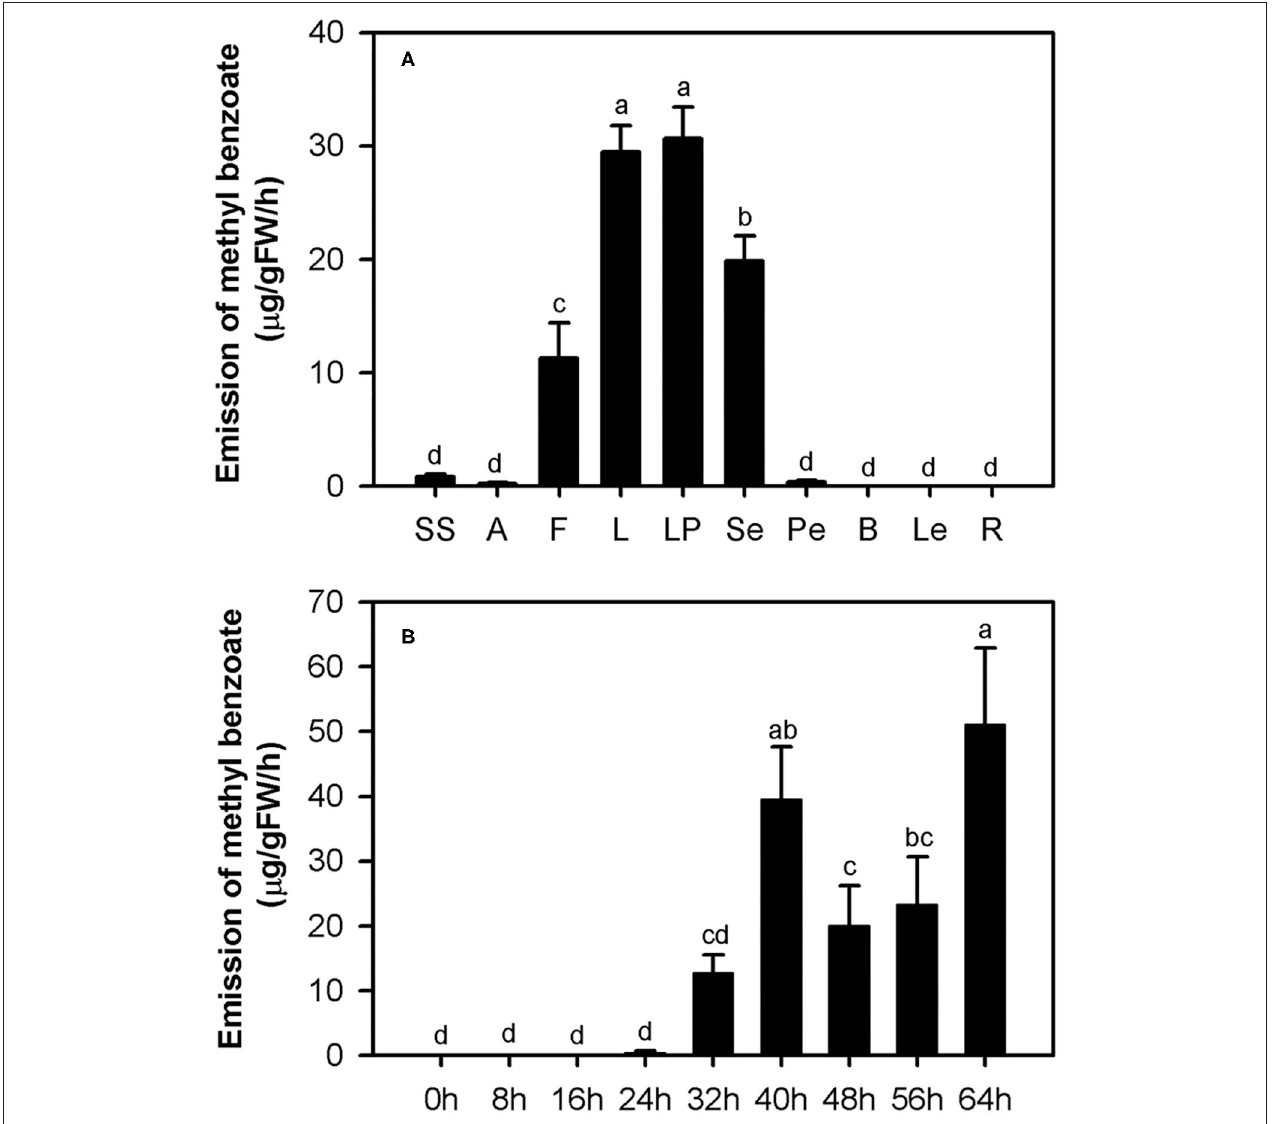
FIGURE 2 | Emission of methyl benzoate in H. coronarium . (A) Methyl benzoate emission pattern in different tissues of H. coronarium . SS, styles and stigmas; A, anthers; F, filaments; L, labella; LP, lateral petals; Se, sepals; Pe, pedicels; B, bracts; Le, leaves, R, rhizomes. (B) Changes of floral volatile methyl benzoate during flower development. Error bars indicate standard deviation of three biological replicates. Different lowercase letters labeled on bars indicate statistically significant differences at the level of P <